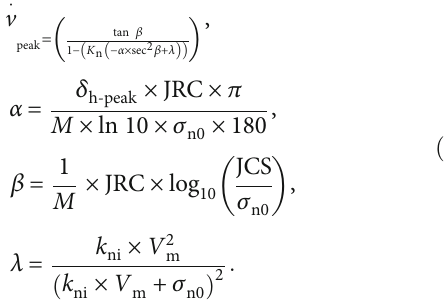
is 1 MPa, (b) the σ n0